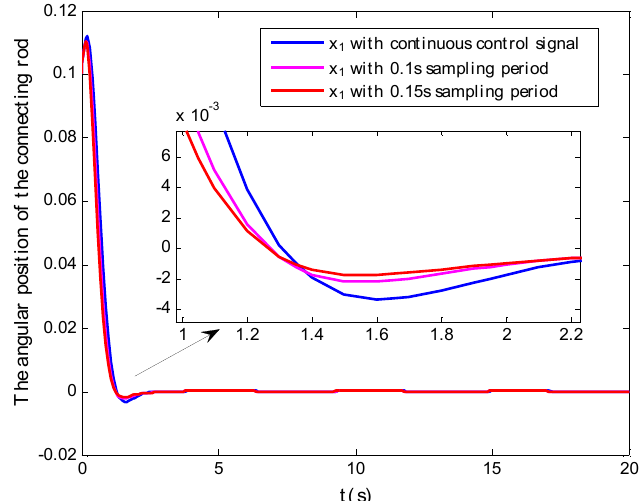
Figure 2. The trajectories of state x 1 with different sampling periods.